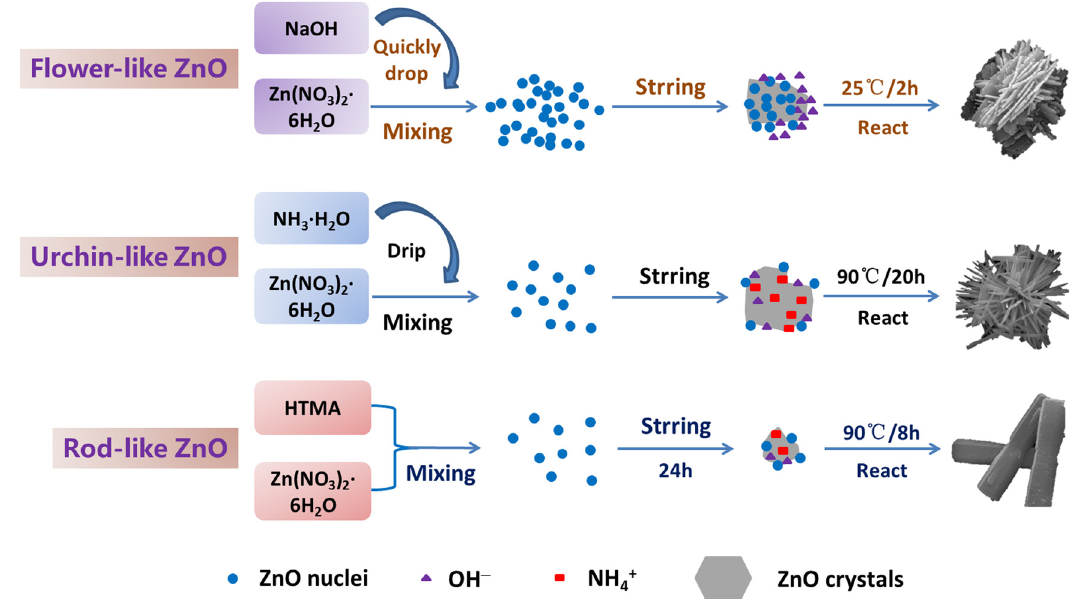
Figure 2: Preparation fl ow chart of ZnO with di ff erent